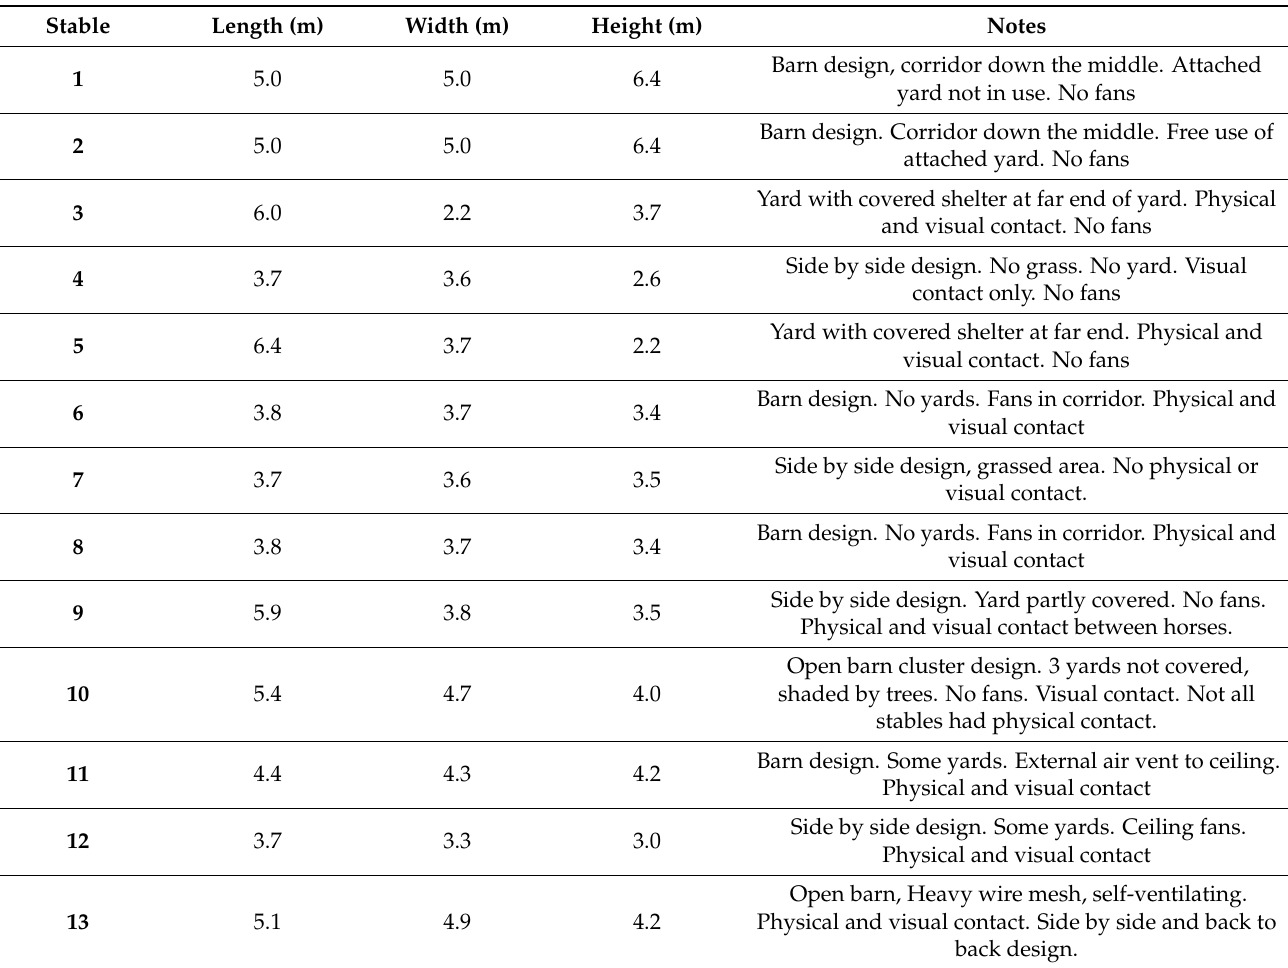
Table A1. Description of the individual stables of the training stables ( n = 13) in the survey of TBR